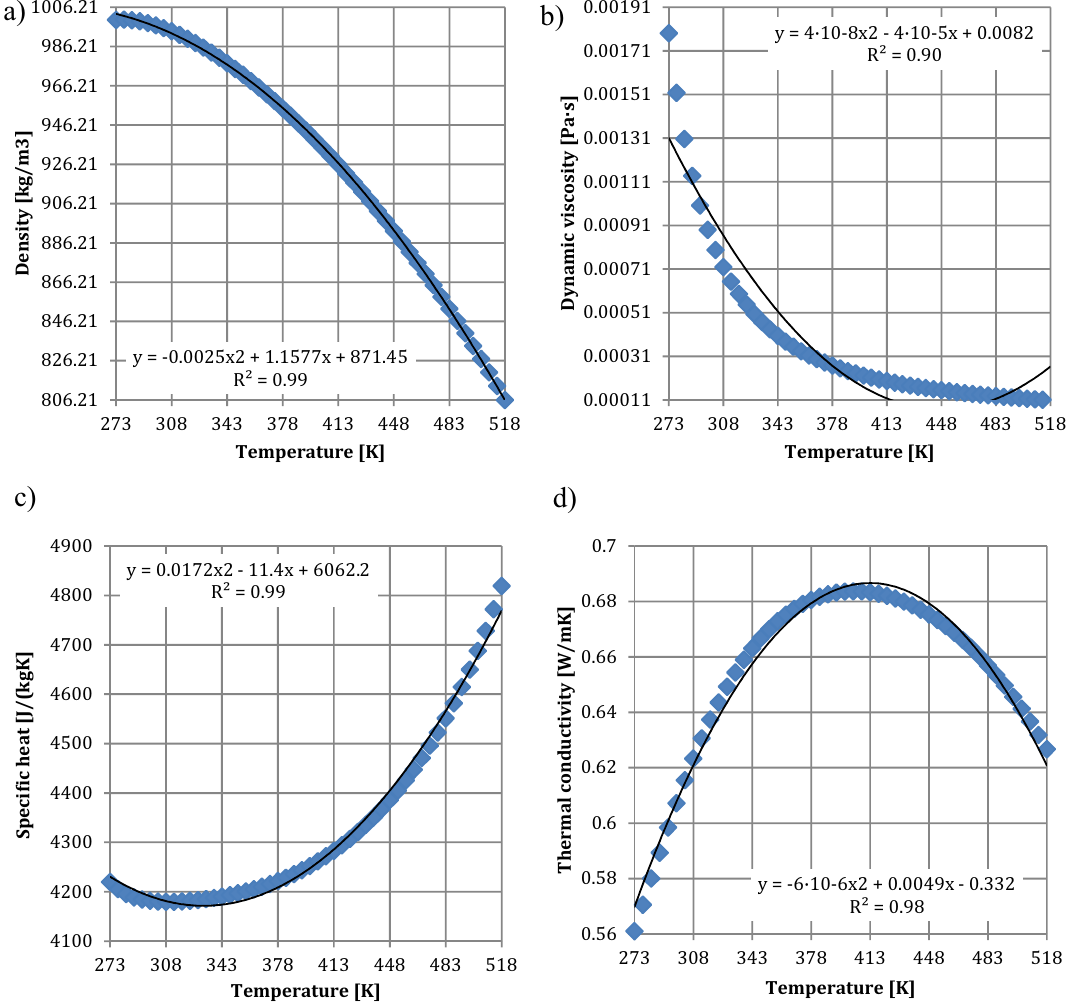
Figure 9. Parameters of the water as a function of temperature: ( a ) density, ( b ) dynamic viscosity, ( c ) specific heat, ( d ) thermal